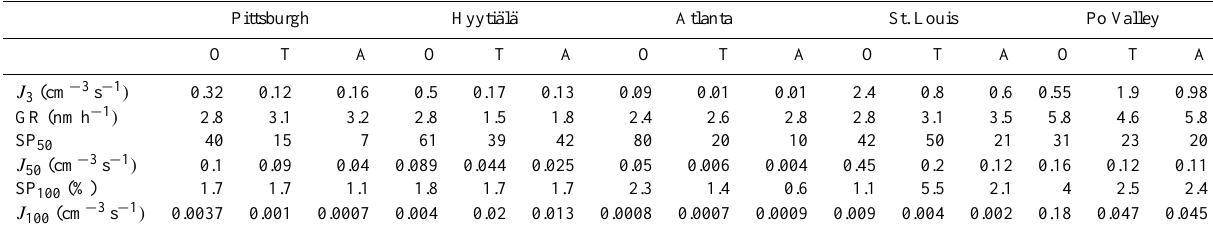
Table 2. Median values for each metric for each site. O = observed, T = ternary simulation, A = activation simulation. Pittsburgh Hyyti¨al¨a Atlanta St. Louis Po Valley